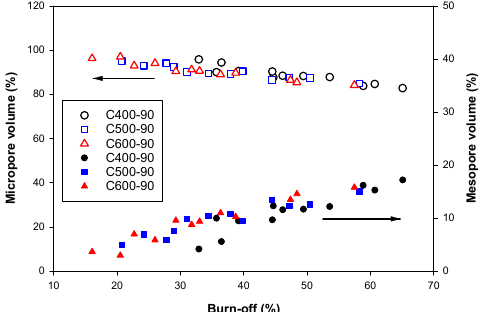
Figure 6. Effects of char burn - off on the percentage of micropore volume and mesopore volume. The blank symbols represent the micropore volume while the solid symbols represent the mesopore volume.